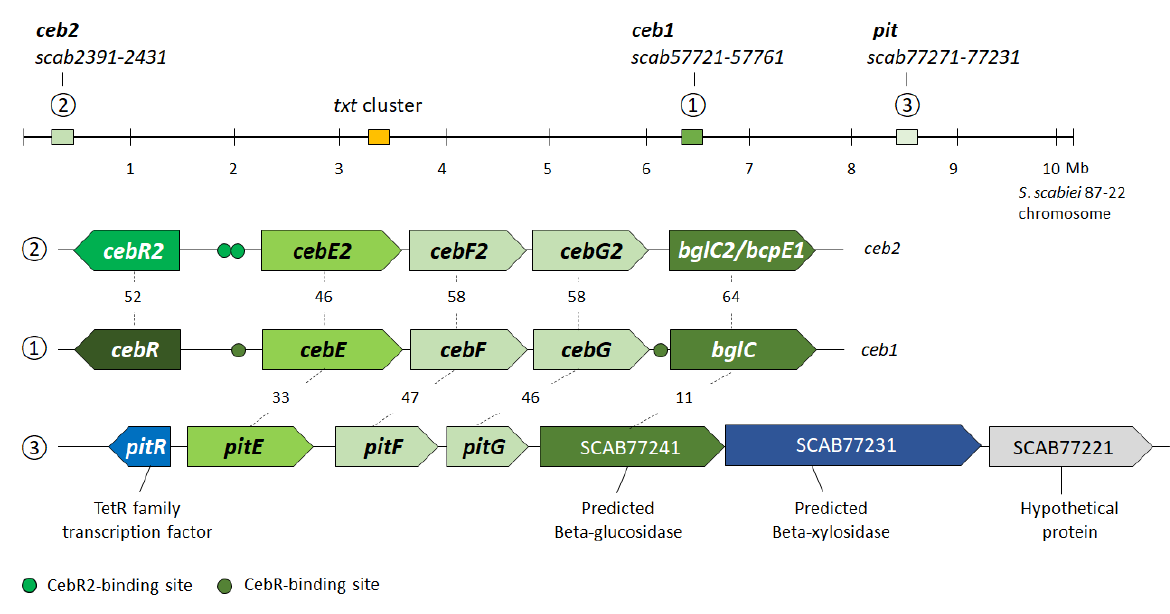
Figure 1. Chromosome position, gene organization, and identity levels of the three sugar ABC-type transporters presumed to interact with cello-oligosaccharide elicitors in S . scabiei 87-22. Numbers between ORFs are the percentage of amino acid identity between the corresponding homologous proteins.